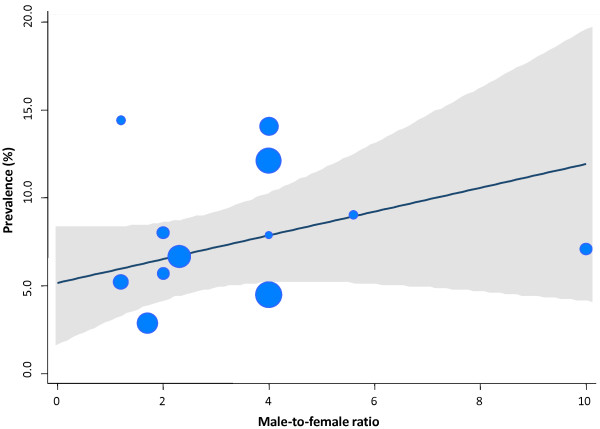
Relationship between male-to-female ratio and the prevalences of ADHD among children and adolescents in Spain. Meta-regression analysis. Note: The size of the bubble is inversely related to the variance of the study. The solid line represents the linear regression (male-to-female ratio as the meta-independent variable). The shaded area corresponds to the confidence intervals of the prediction.